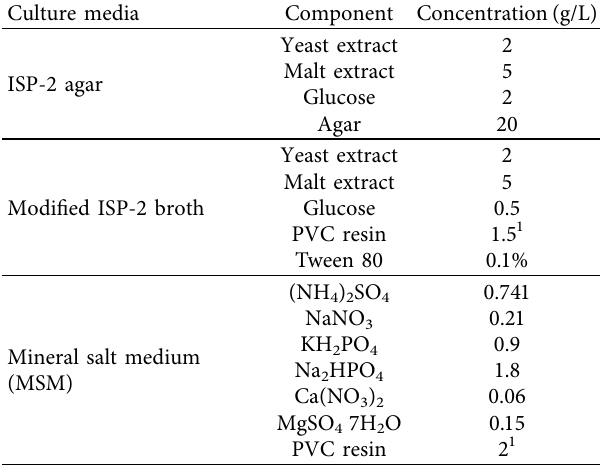
Table 1: Culture media